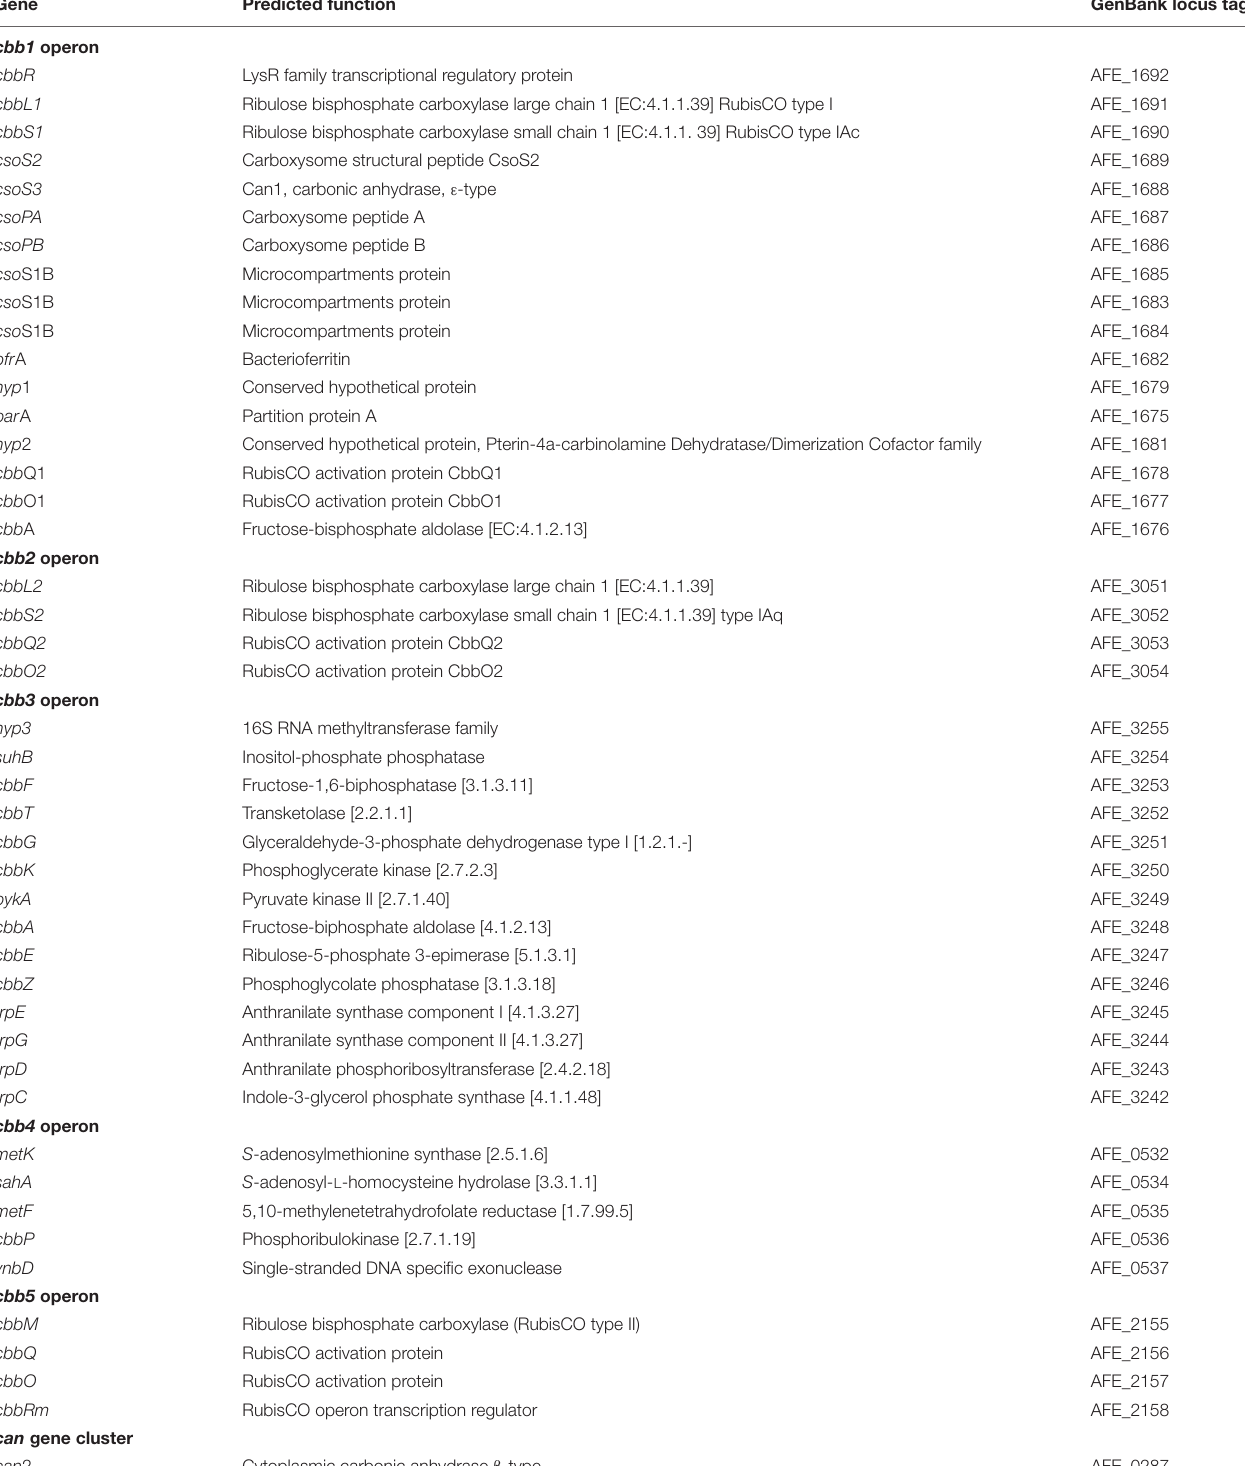
TABLE 2 | Genes, predicted functions, and GenBank locus tags for the A. ferrooxidans CBB cycle and CCM genes used in this study. Gene Predicted function GenBank locus tag